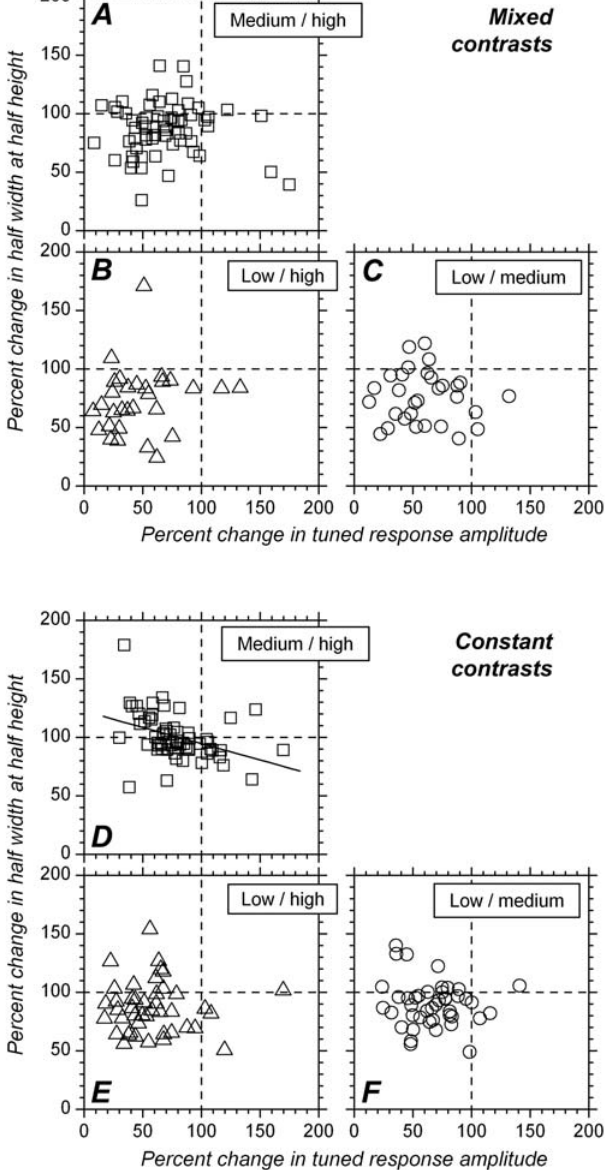
percent change in tuned response amplitude. In these scatter plots, the x -axis represents percent change in tuned response amplitude and the y -axis represents percent change in HWHH. A. Medium vs. high contrast, mixed contrasts condition. B. Low vs. high contrast, mixed contrasts condition. C. Low vs. medium contrast, mixed contrasts condition. In these three scatter plots, most data points are located in the quadrant delimited by 0 and 100% on both x and y axis, indicating that most cells showed both reduced response amplitude and reduced HWHH when contrast was decreased. However, the two variables were not significantly correlated. D. Medium vs. high contrast, constant contrast condition. E. Low vs. high contrast, constant contrast condition. F. Low vs. medium contrast, constant contrast condition. In the scatter plots in E and F, most data points can be found in the quadrant delimited by 0 and 100% on both x and y axes, indicating that most cells showed both reduced response amplitude and reduced HWHH when contrast was decreased. This is not the case for the scatter plot in D, reflecting the fact that orientation tuning width was not different, on average, between medium and high contrast after adaptation. There is, however, a significant inverse relationship between the two variables in this case. The line corresponds to the linear relationship between the two